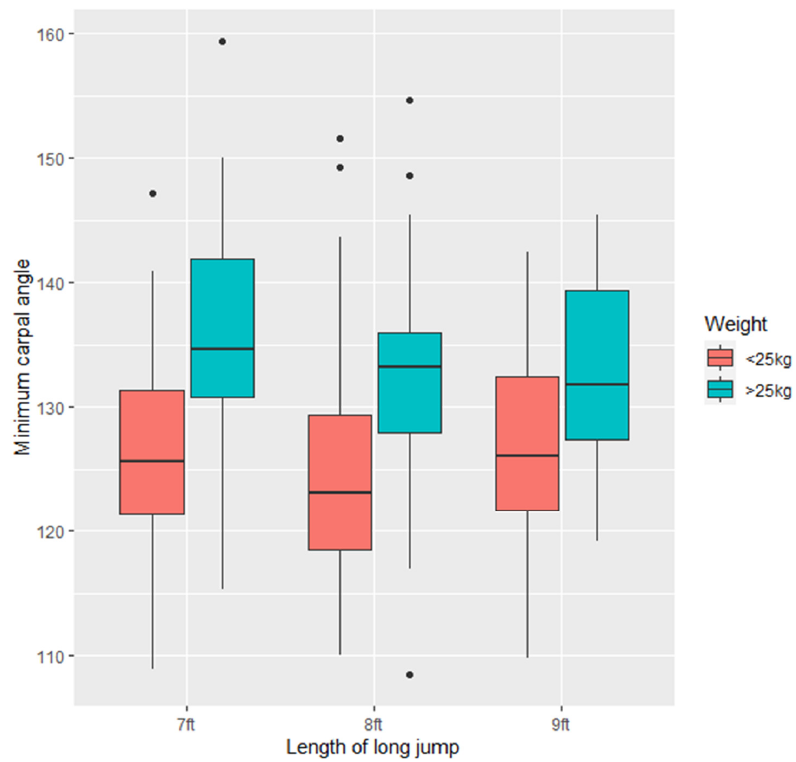
Figure 7. Minimum apparent carpus angle (degrees) across all the study dogs ( n = 21) at the three long jump lengths (7 ft, 8 ft, 9 ft). Dogs that were >25 kg had smaller minimum shoulder angles on landing than dogs apparent shoulder angle and length of the jump ( p > 0.05). There was no difference in variation of minimum shoulder angle in dogs <25 kg or >25 kg (Figure 8).